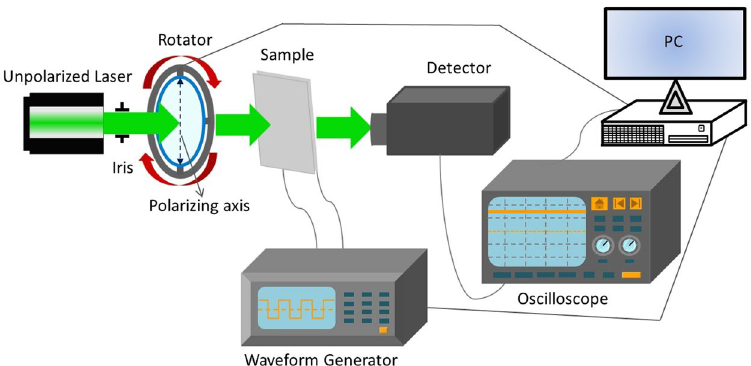
Figure 3. Schematic setup for optical measurements of Ch-LC-grating devices.